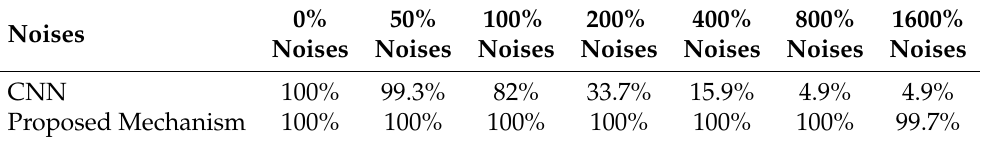
Table 2. Comparison of identification accuracy between CNN and proposed mechanism for 8 voxel object.